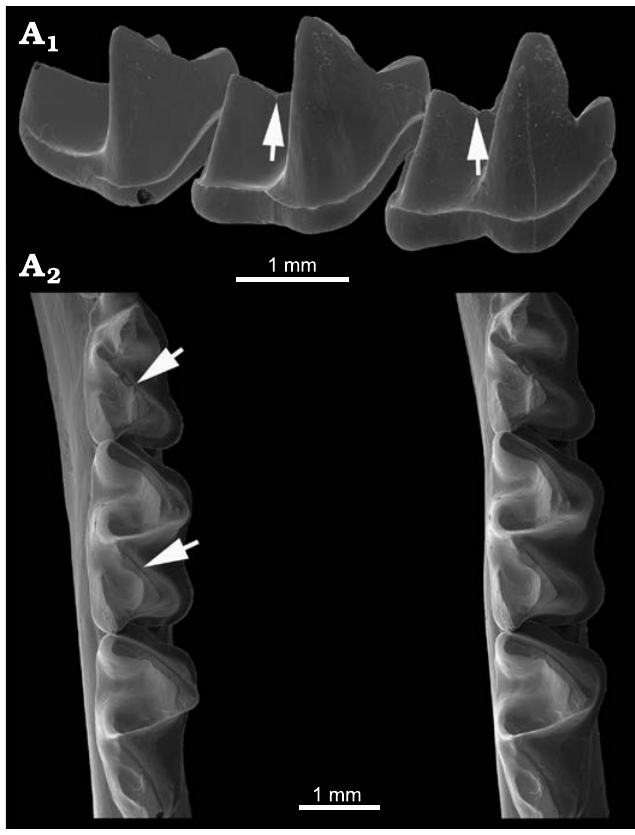
Fig. 2. Megadermatid bat Megaderma spasma (Linnaeus, 1758) (AMNH 216806) from Malaysia, Recent. Lower molars showing weak carnassi- form notches in the cristids obliqua of m1 and m2 (indicated by arrows) in anterolabial view (A 1 ), note that the entocristids are partly visible in the immediate background behind the cristid obliqua in m1 and m2; occlusal view (stereopair, A 2 ), arrows indicate notches in the cristids obliqua that are developed to a lesser degree than those in the trigonid crests. Note entocristids with indistinct